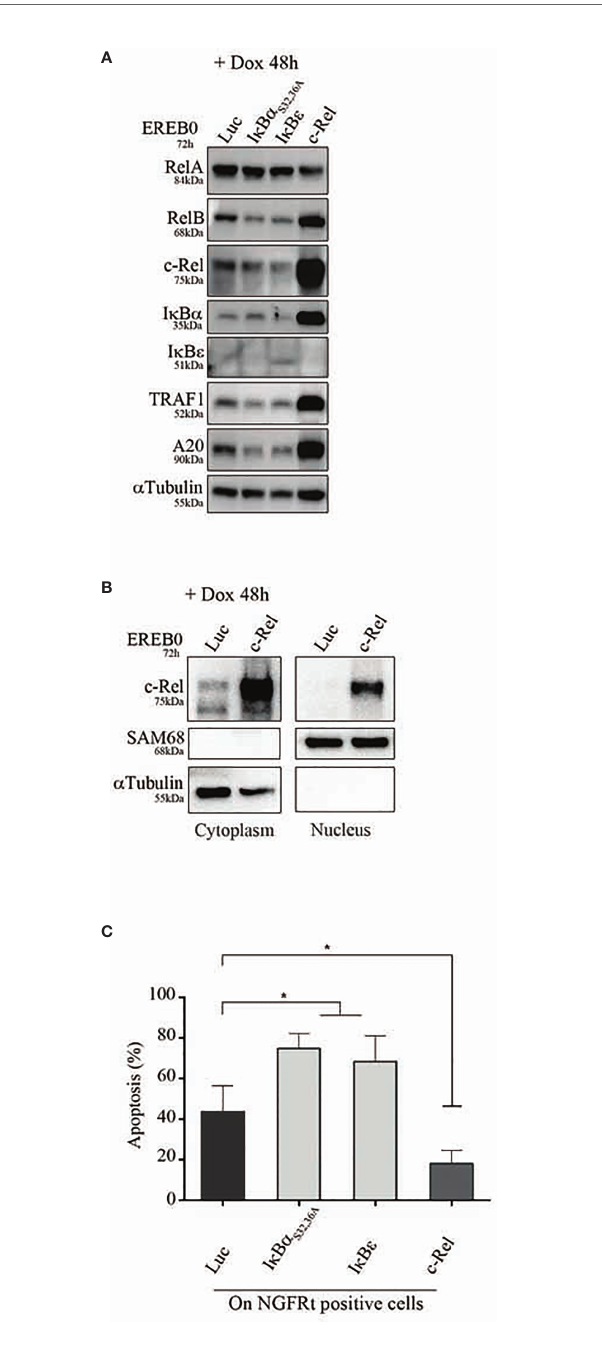
FIGURE 7 | Apoptosis of c-Rel overexpressed human B-cells. EREB2-5 cells were stably transfected with the doxycycline-regulatable pRT-1 vector coding for Luciferase (Luc), I k B a S32,36A , I k B e , or c-Rel. After estradiol starvation for 24 h (EREB0), cells were treated with doxycycline (+ Dox) for 48 h. (A) Immunoblots detecting the expression of RelA, RelB, c-Rel, I k B a , I k B e , TRAF1, A20 as well as a Tubulin as loading control. (B) Detection of cytoplasmic and nuclear c-Rel protein by immunoblot. SAM68 and a Tubulin revelations are nuclear and cytoplasmic markers, respectively. (C) Percentages of Annexin-V- positive cells gated on NGFRt positive cells. Statistically signi fi cant difference (Mann – Whitney test) is indicated by *( p ≤ 0.05